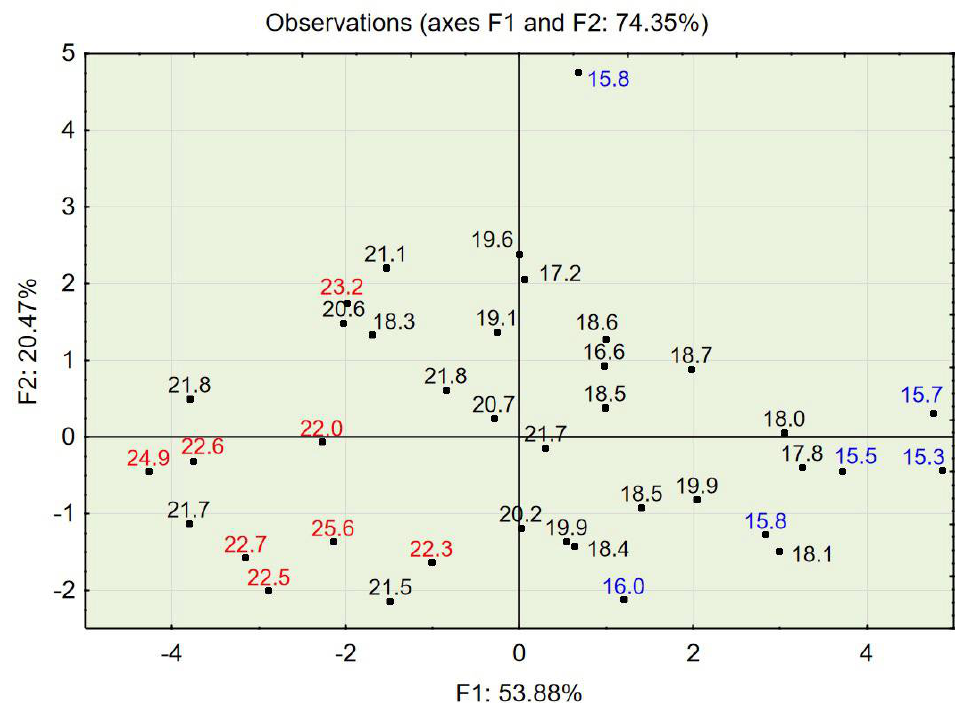
Figure 6. PCA with object grouping in a two-dimensional space on the basis of concrete composition in relation to concrete properties. Compressive strength: red represents a strength of 22 MPa or above, and blue represents a strength of 16 MPa or below.